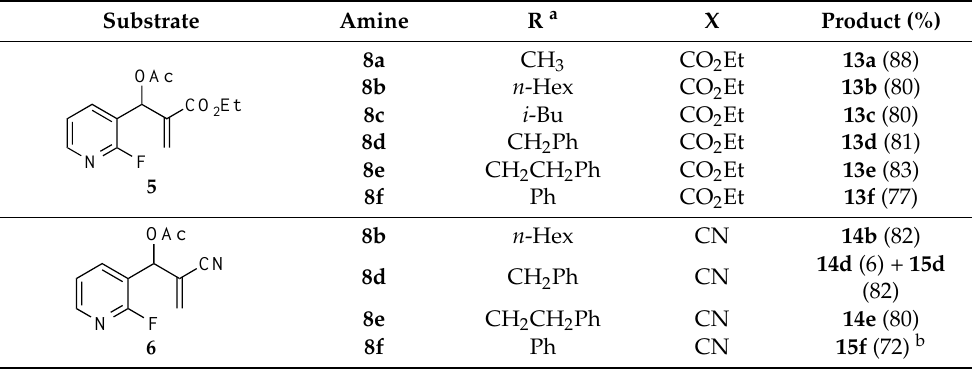
a R = alkyl/phenyl group of a primary amine. b The double bond-migrated product 15f was the only product. Table 3. Synthesis of ethyl 1-alkyl-1,2 and 1,4-dihydronaphthyridine-3-carboxylates.